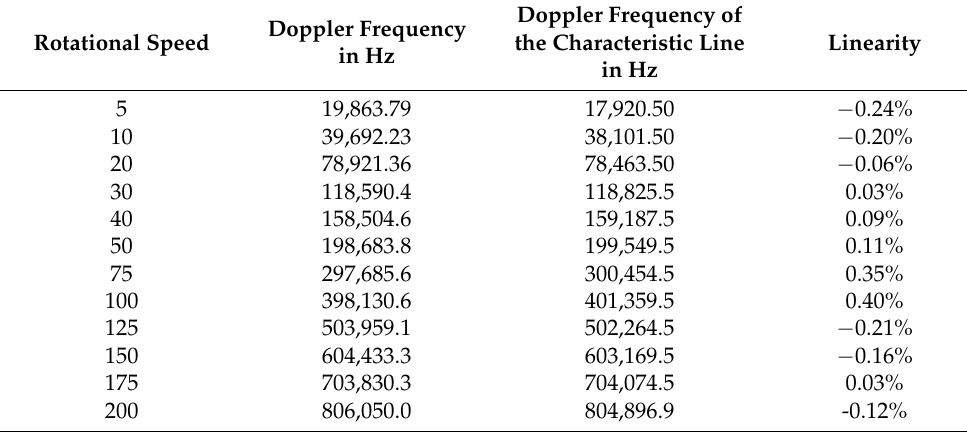
Figure 17. Linearity between Doppler frequency and rotational speed (Reprinted with permission from [18] © The Optical Society). Table 3. Linearity of the average values from 50 data sets for each rotational